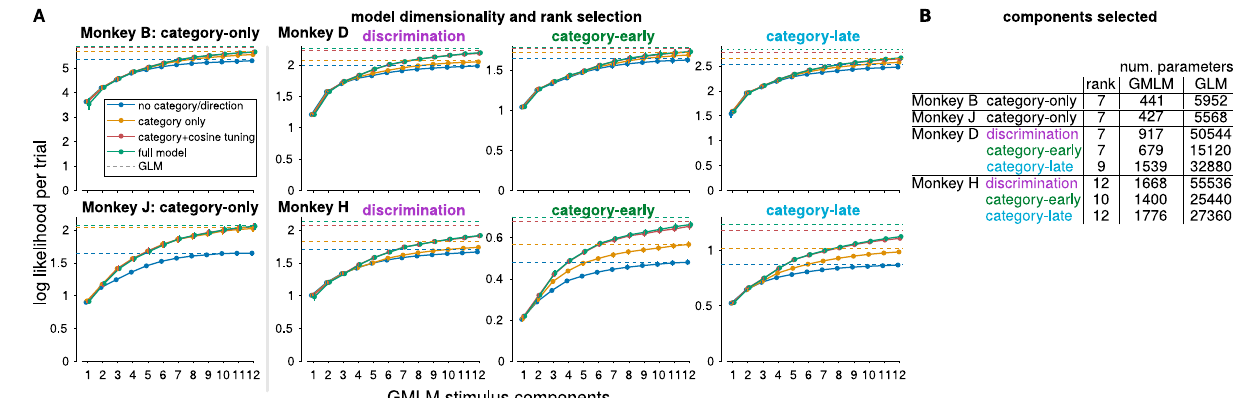
Fig. 4 | A low-rank model captures task-relevant LIP activity during the DMS andDMCtasks.A Wedeterminedthedimensionalityofthepopulationactivityby estimating model fi tness while increasing the number of components. Each point shows the mean cross-validated log-likelihood per trial of the GMLM relative to a baseline model without any stimulus terms (i.e., the “ rank 0 ” model) for two monkeys during the category task. The log-likelihood shows the average log probabilityofobservingthespiketrainfromawithheldtrialfromoneneurongiven the model relative to the log probability of that observation under the null model without stimulus-dependent terms. In a Gaussian model, the log-likelihood is